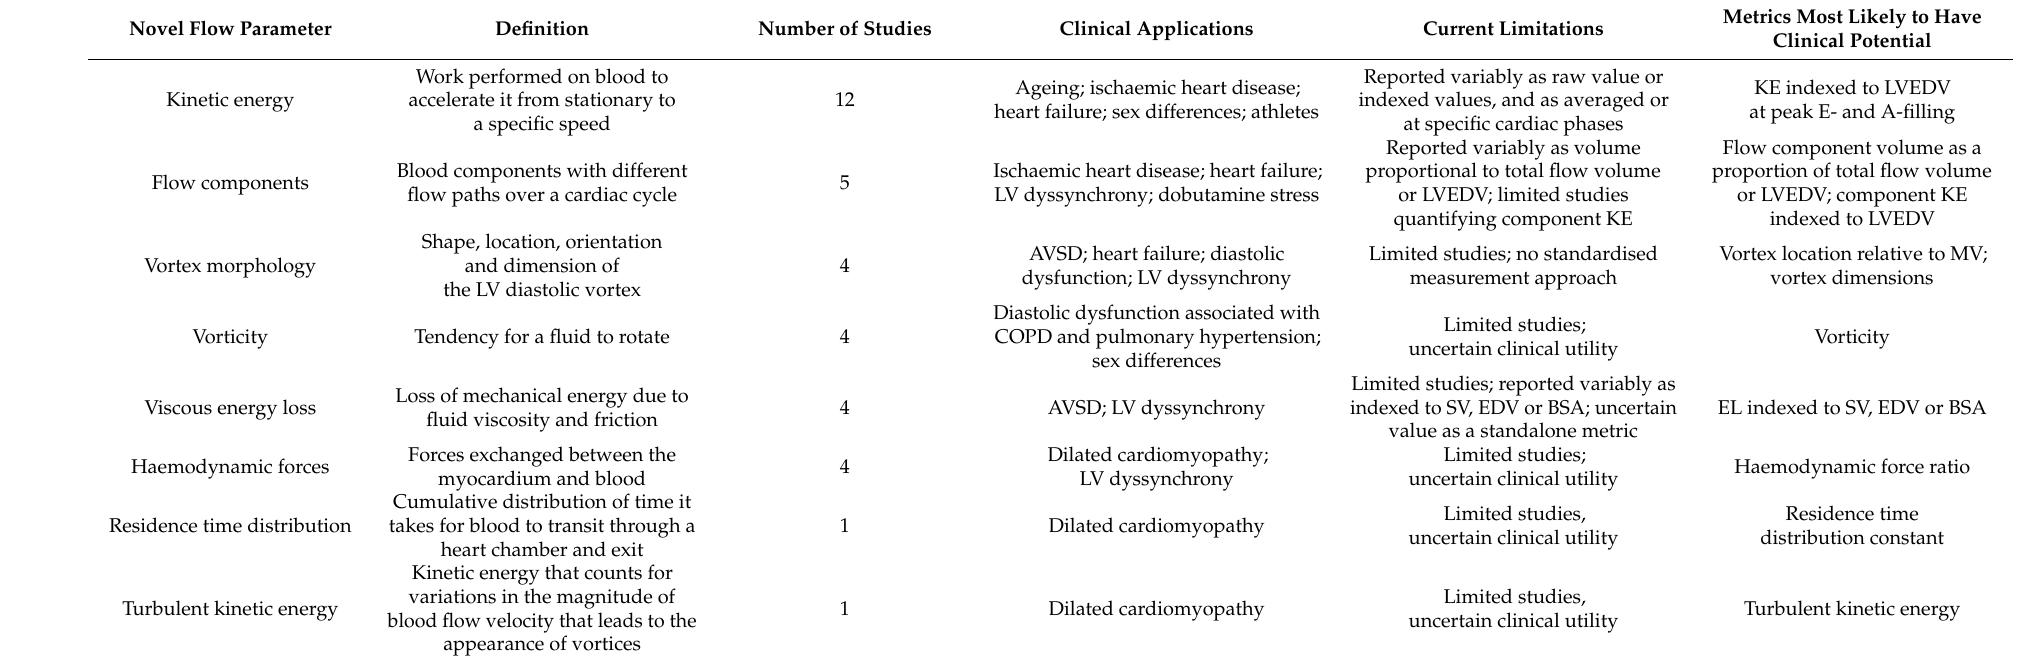
Table 2. Summary of flow parameters and clinical